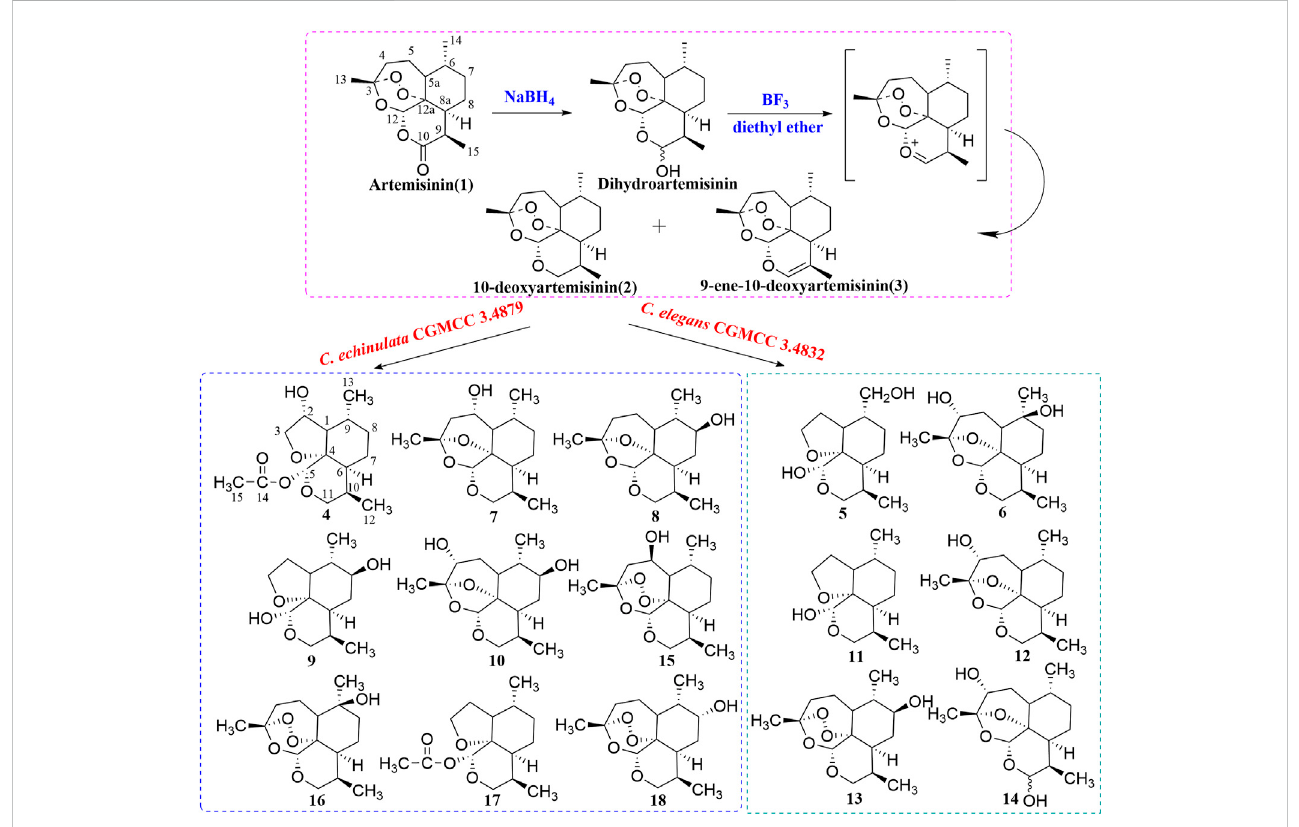
FIGURE 1 Synthesis route of 10-deoxyartemisinin and its metabolites by C. elegans and C. echinulata .